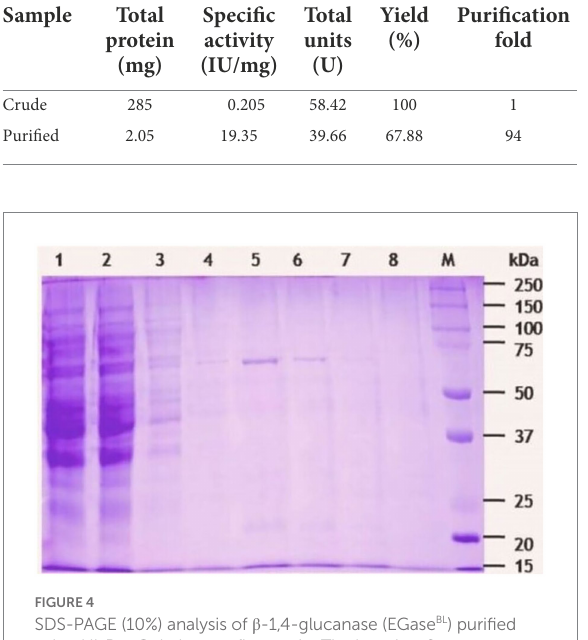
FIGURE 4 SDS-PAGE (10%) analysis of β -1,4-glucanase (EGase BL ) purified using HisPur Cobalt superflow resin. The lane 1 to 9 represents total lysate, flow through, wash, elute 1(10 mM imidazole), elute 2 (50 mM imidazole), elute 3 (100 mM imidazole), elute 4 (150 mM imidazole), blank, and protein marker,